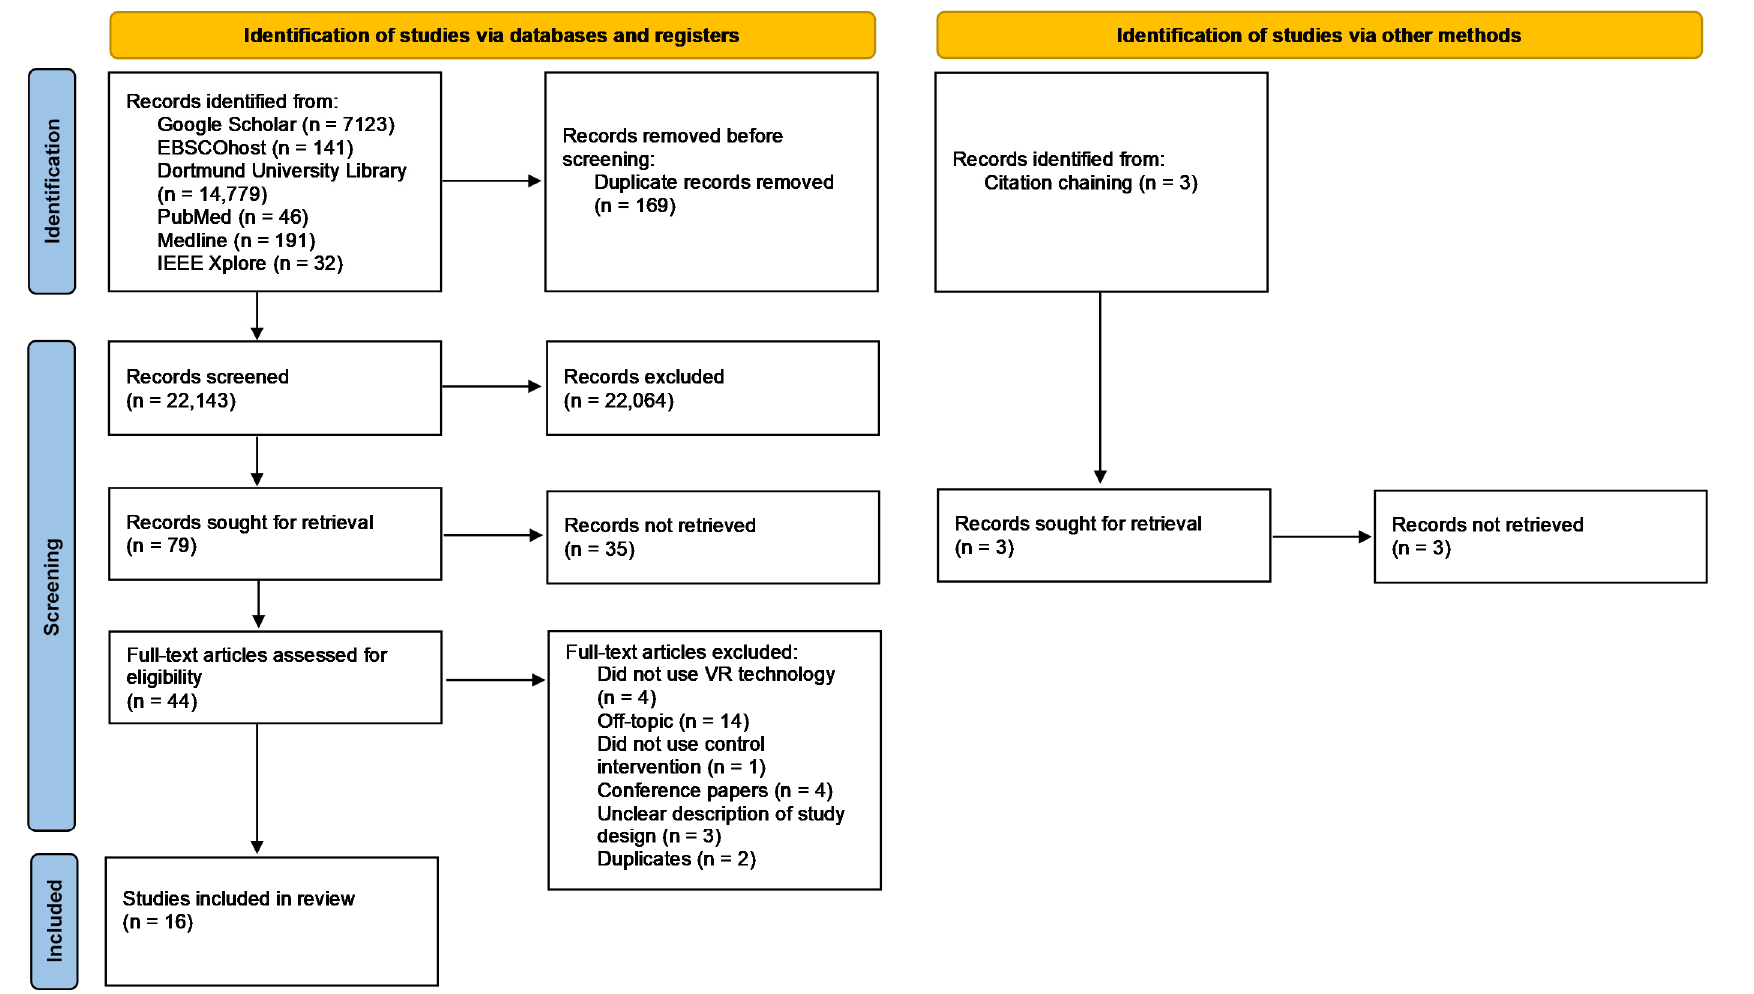
Figure 1. Search strategy for the inclusion and exclusion of studies based on a modified version of PRISMA flow diagram [60].